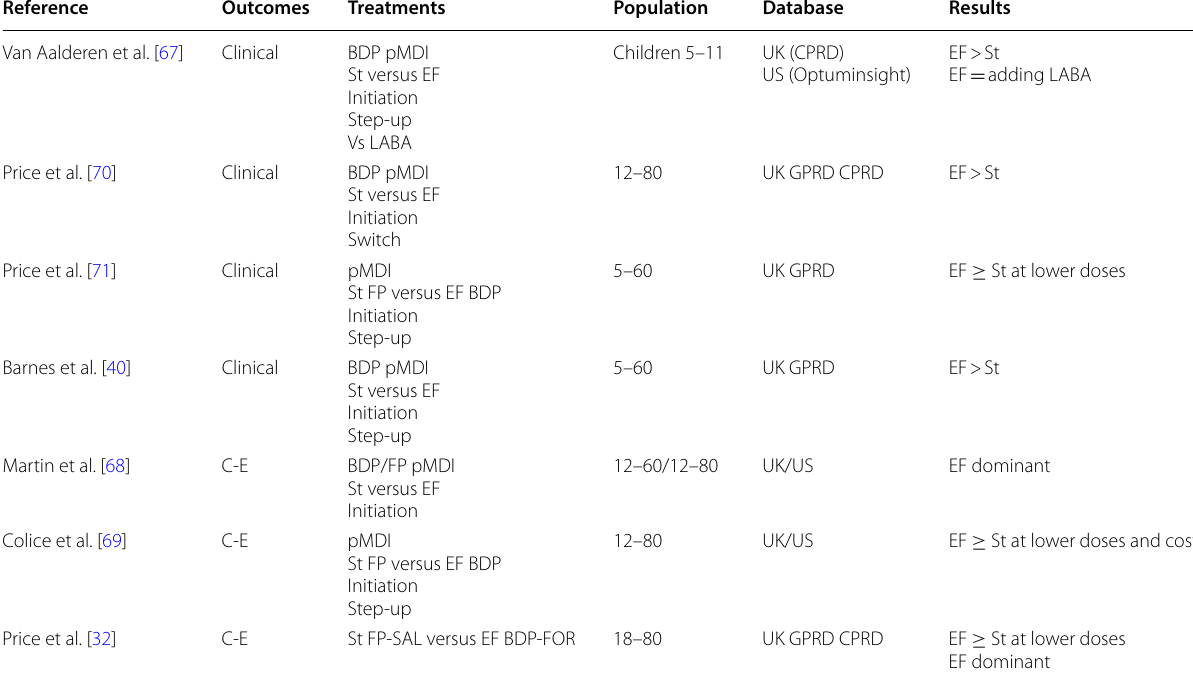
EF extra-fine, St standard size, BDP beclomethasone dipropionate, SAL salmeterol; FOR , formoterol, FP fluticasone propionate, pMDI pressurized metered-dose inhaler